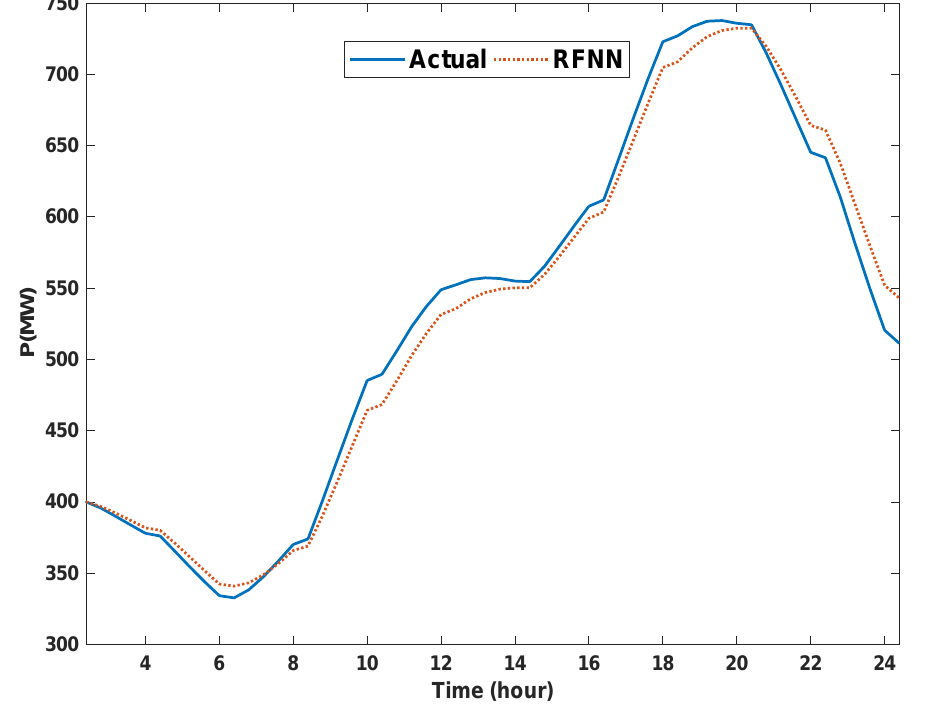
Figure 11. Forecasting result for 20 October 2019. Further, the load consumption is predicted on 30 July 2019, which is a non-holiday day with temperatures of 21 to 25 ◦ C, and the result is illustrated in Figure 12.